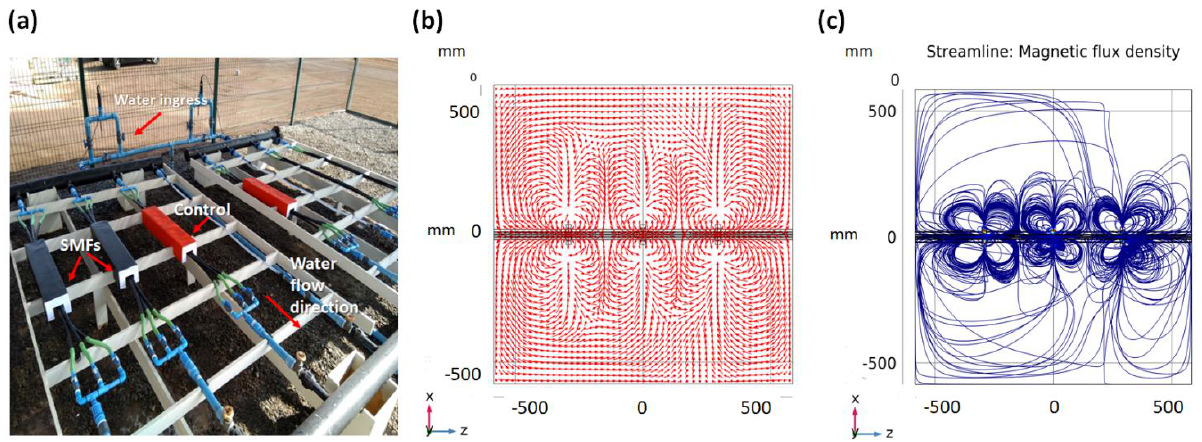
Figure 1. Characterization of the static magnetic field (SMF) in experimental pipeline transportation system. ( a ) picture of the pipeline transportation system used to perform SMF tests; ( b ) direction of the SMF (red arrows); ( c ) shape of the SMF (blue lines).